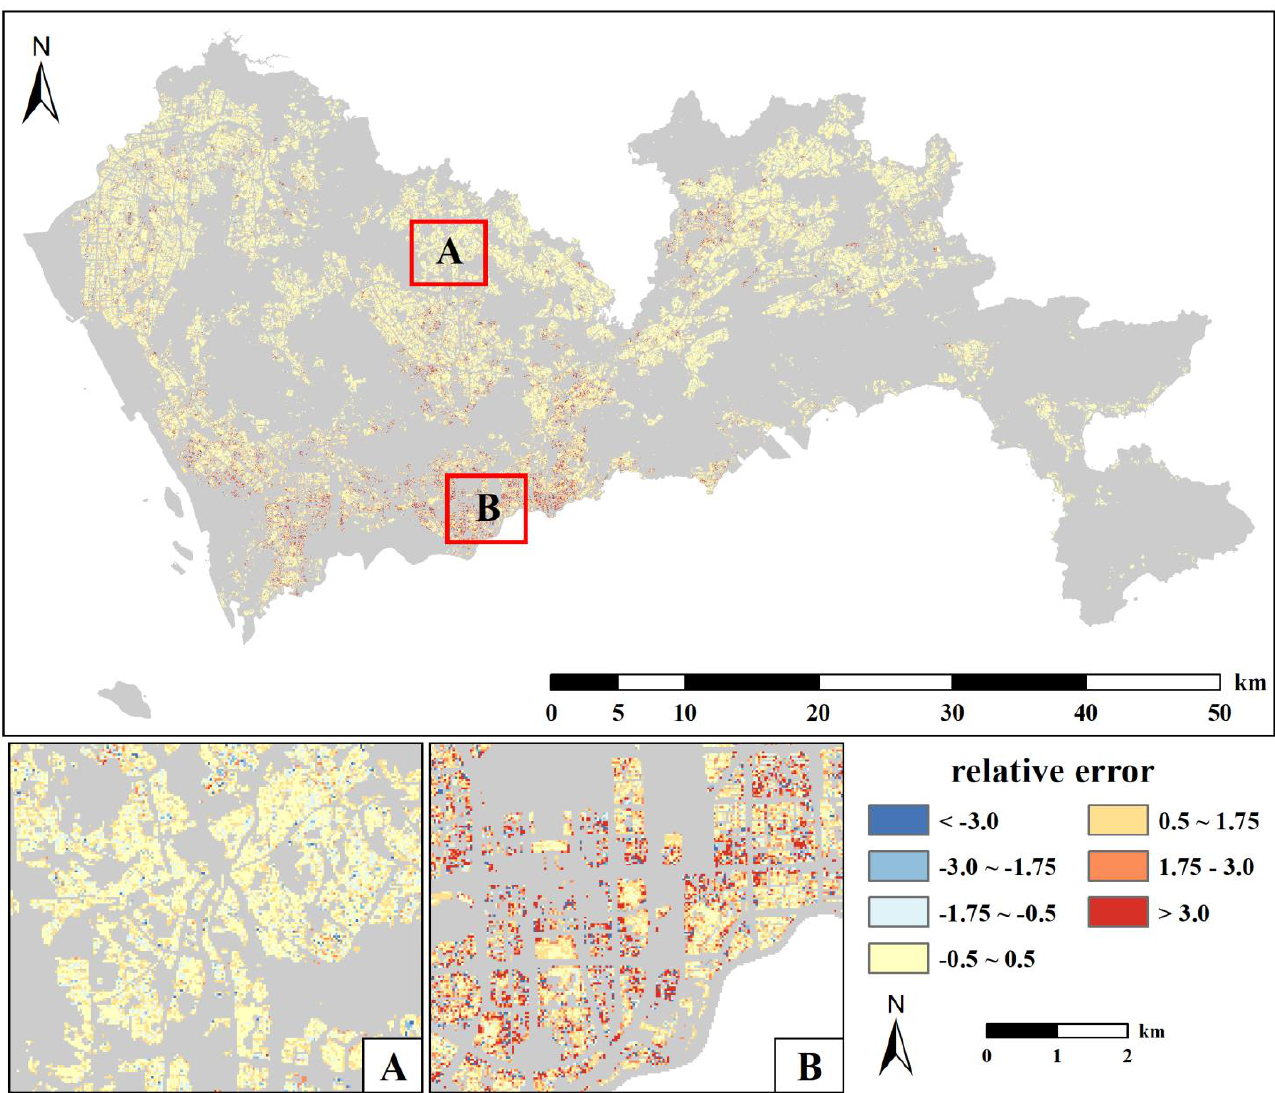
Figure 9. Spatial distribution of relative errors between actual and predicted FAR. (A) The northern region of Longhua District; (B) The southeastern region of Futian District.